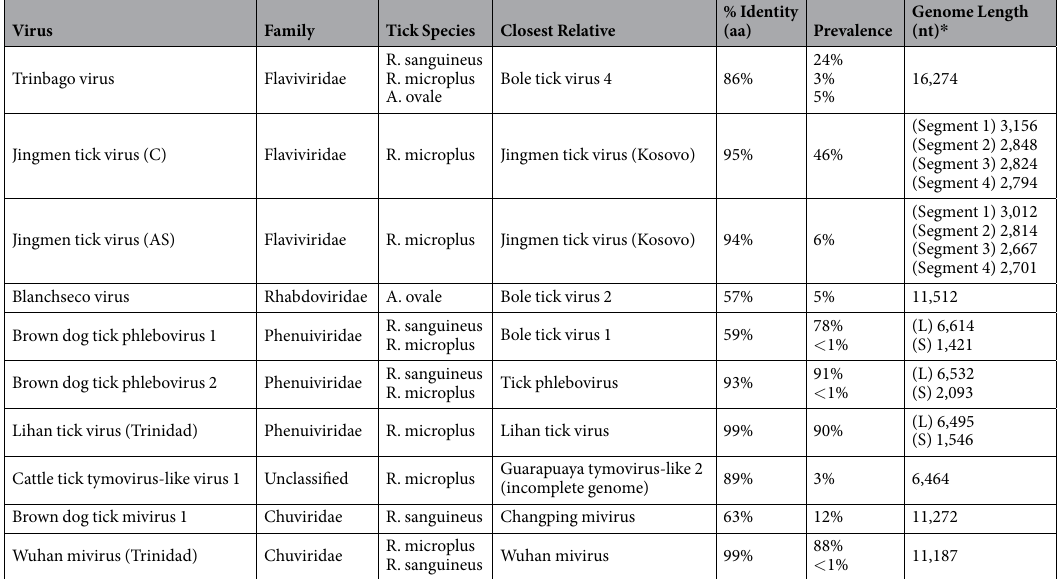
Table 1. Viruses identified in Trinidad and Tobago through high throughput sequencing. * Approximate genome size. All ORFs are complete but the ends were not confirmed as